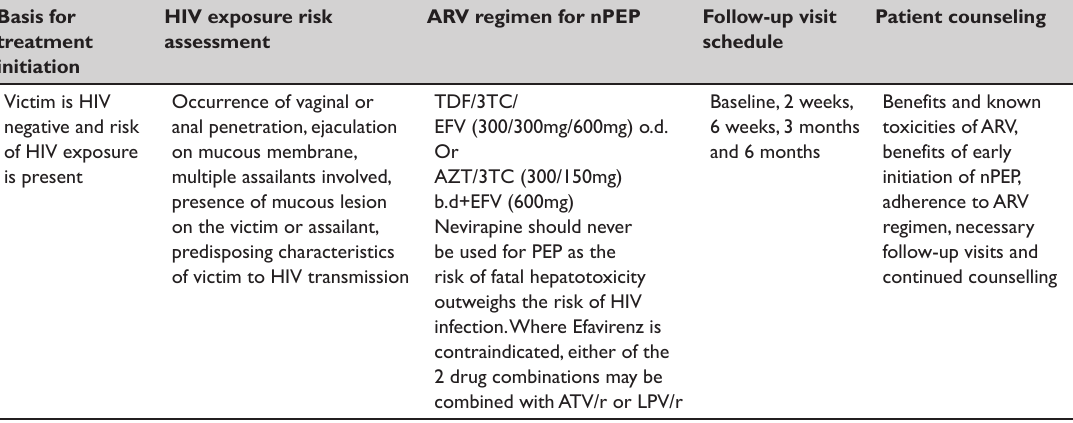
Table 3: Guidelines and Recommendations for nPEP by the Federal Ministry of Health, Nigeria* Basis for treatment